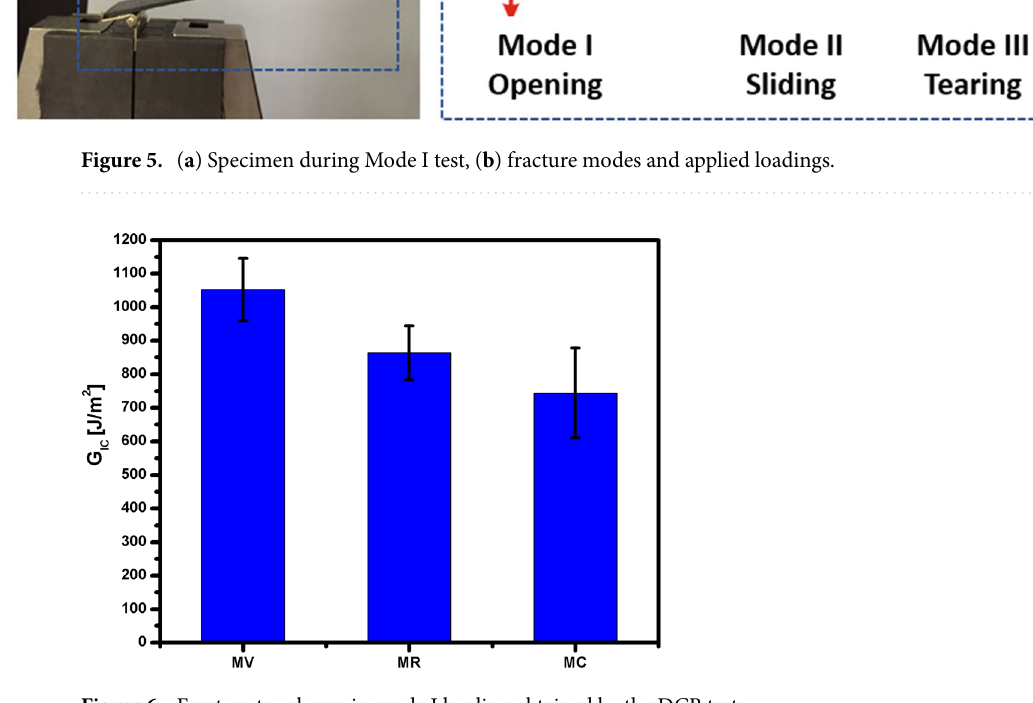
Figure 6. Fracture toughness in mode I loading obtained by the DCB